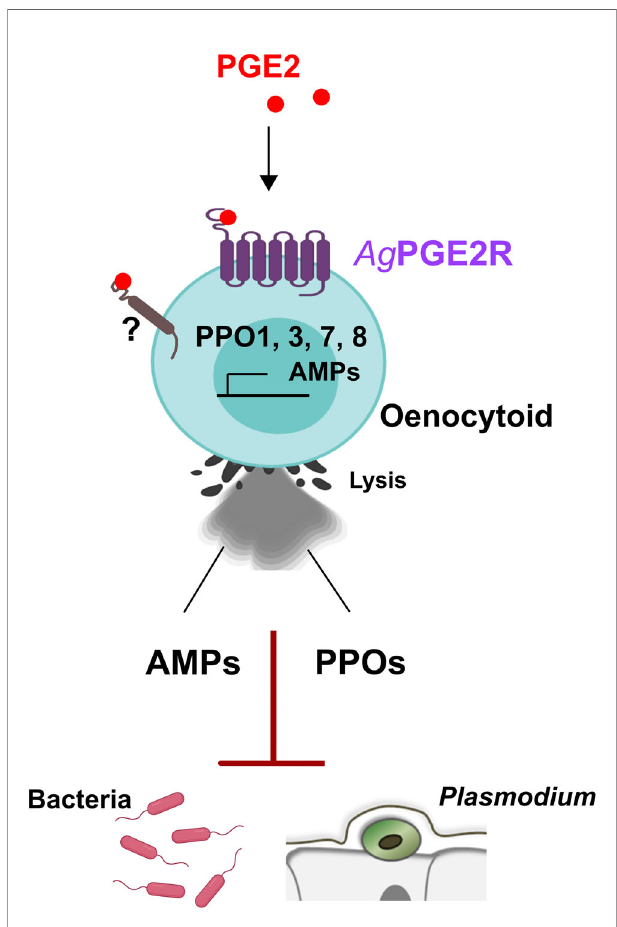
FIGURE 6 | Summary of PGE2 signaling via PGE2R to activate An. gambiae immunity in oenocytoid immune cell populations. We demonstrate that PGE2 interacts with its cognate receptor, Ag PGE2R, to initiate innate immune expression of prophenoloxidases (PPOs) and AMPs in oenocytoid immune cell populations that contribute to bacteria and malaria parasite killing. PGE2 promotes oenocytoid cell lysis by PGE2, yet is independent of PGE2R through an unknown